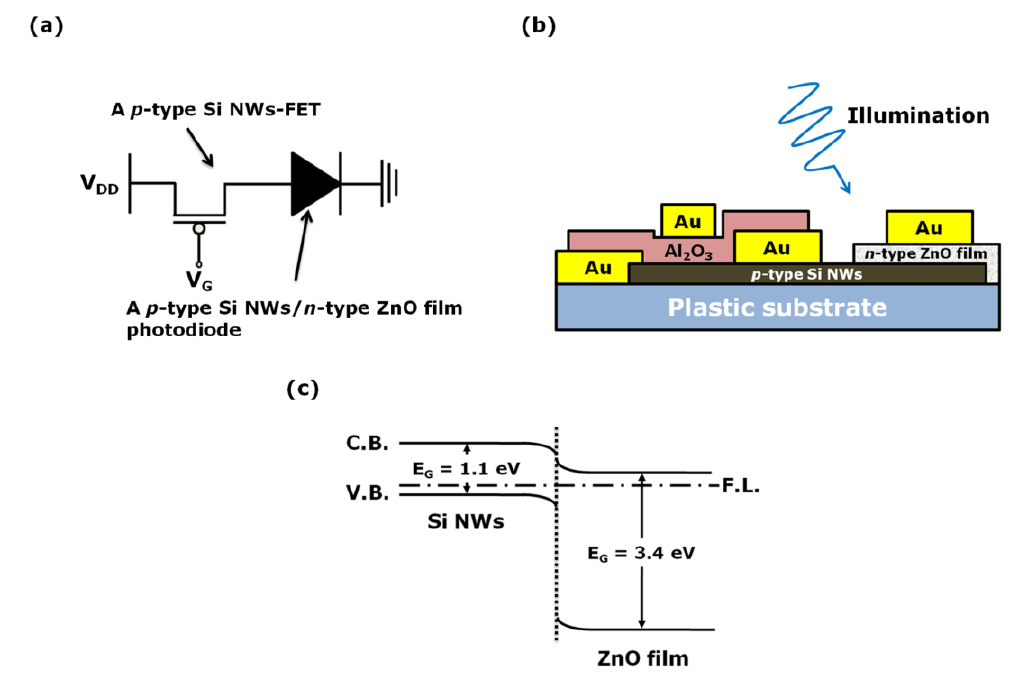
Figure 1. (a) Electronic circuit diagram; (b) cross-sectional schematic; and (c) schematic energy band diagram of a laterally coupled device composed of a p -type Si NWs-FET and a p -type Si NWs/ n -type ZnO film